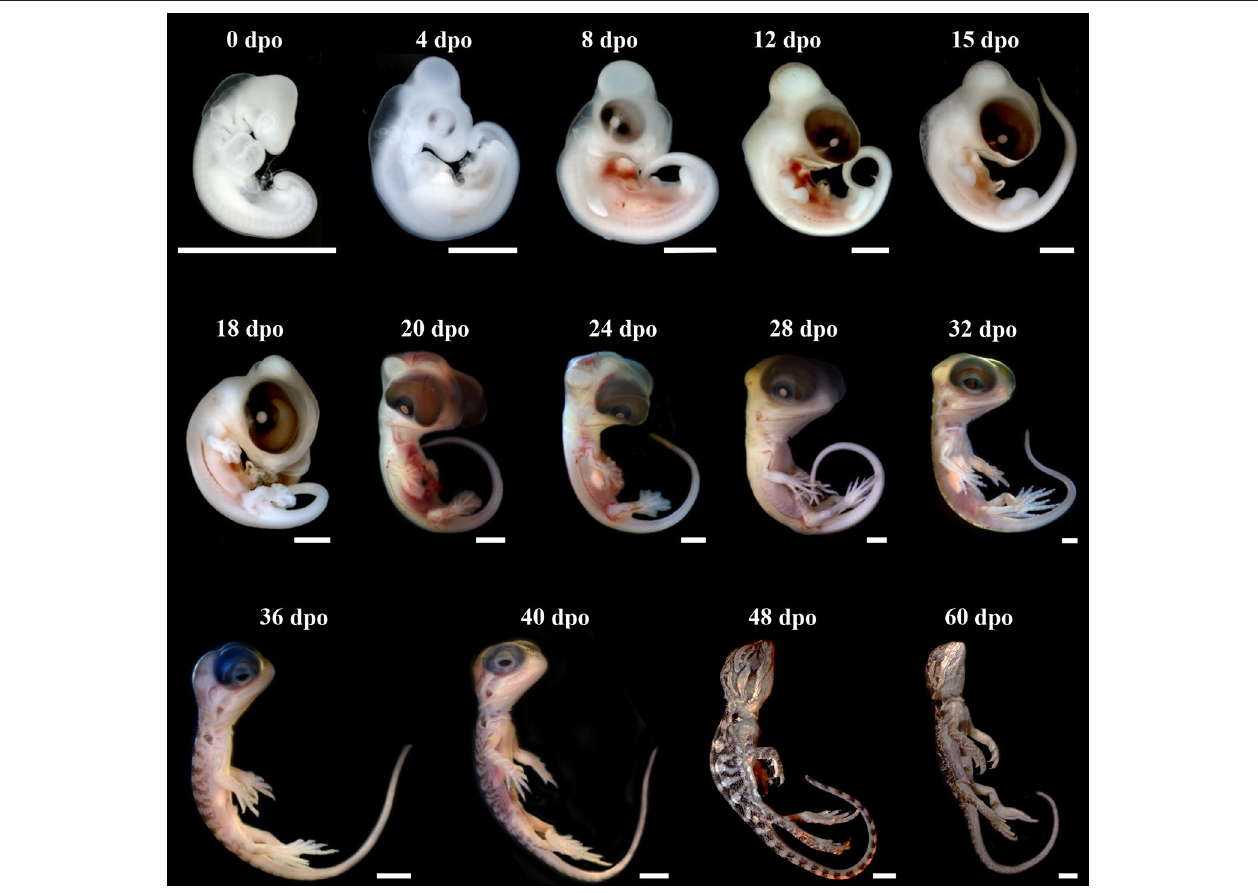
FIGURE 1 | Development of Pogona vitticeps embryos. Lateral views of Pogona vitticeps embryos at various developmental stages (indicated as embryonic days post-oviposition, dpo) used for SES staging. Scale bars = 1mm (0–32 dpo) or 5mm (36–60